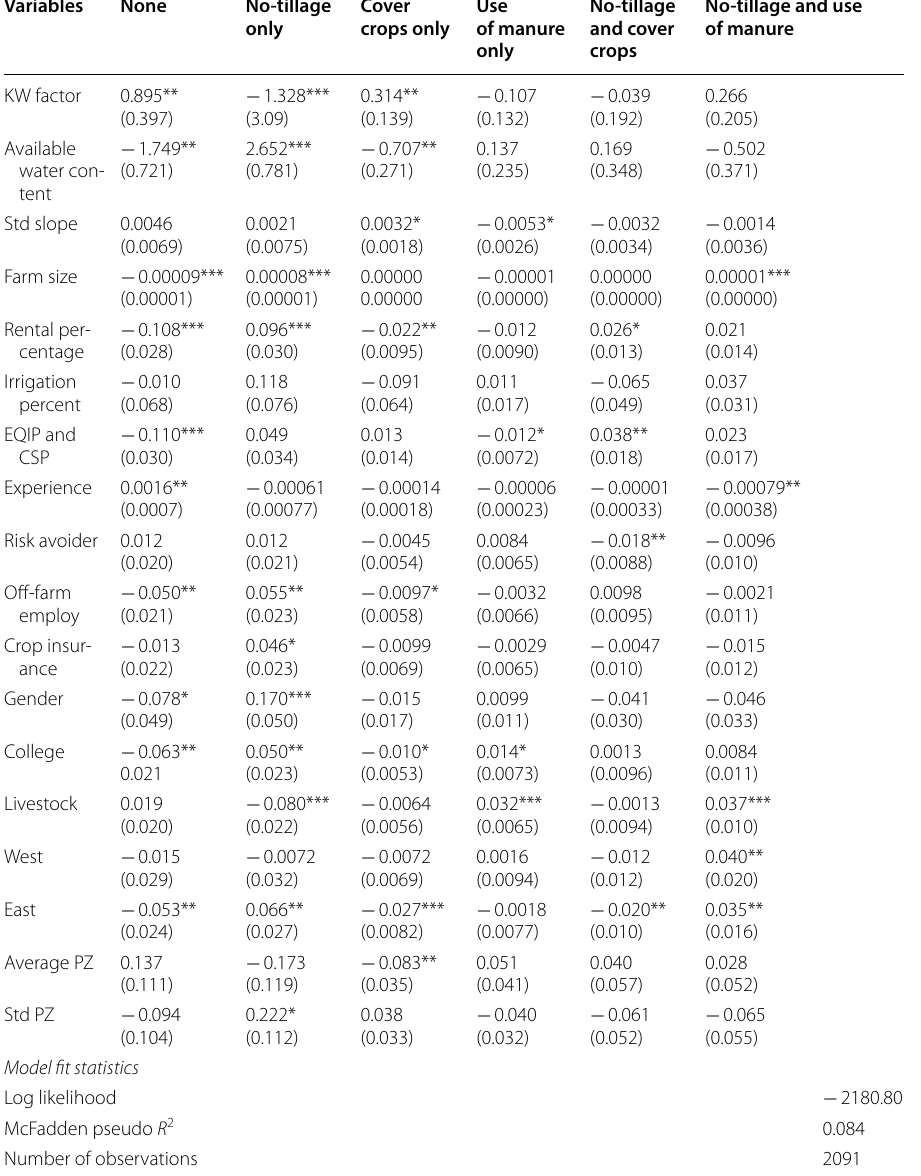
Standard errors are presented in